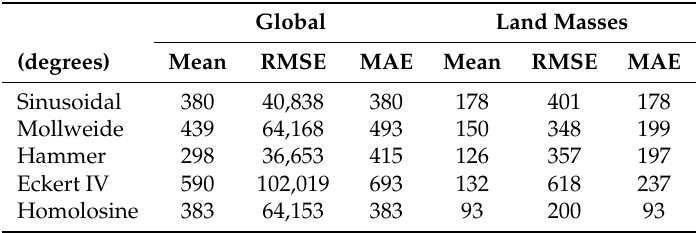
Table 4. Statistics for distance distortions